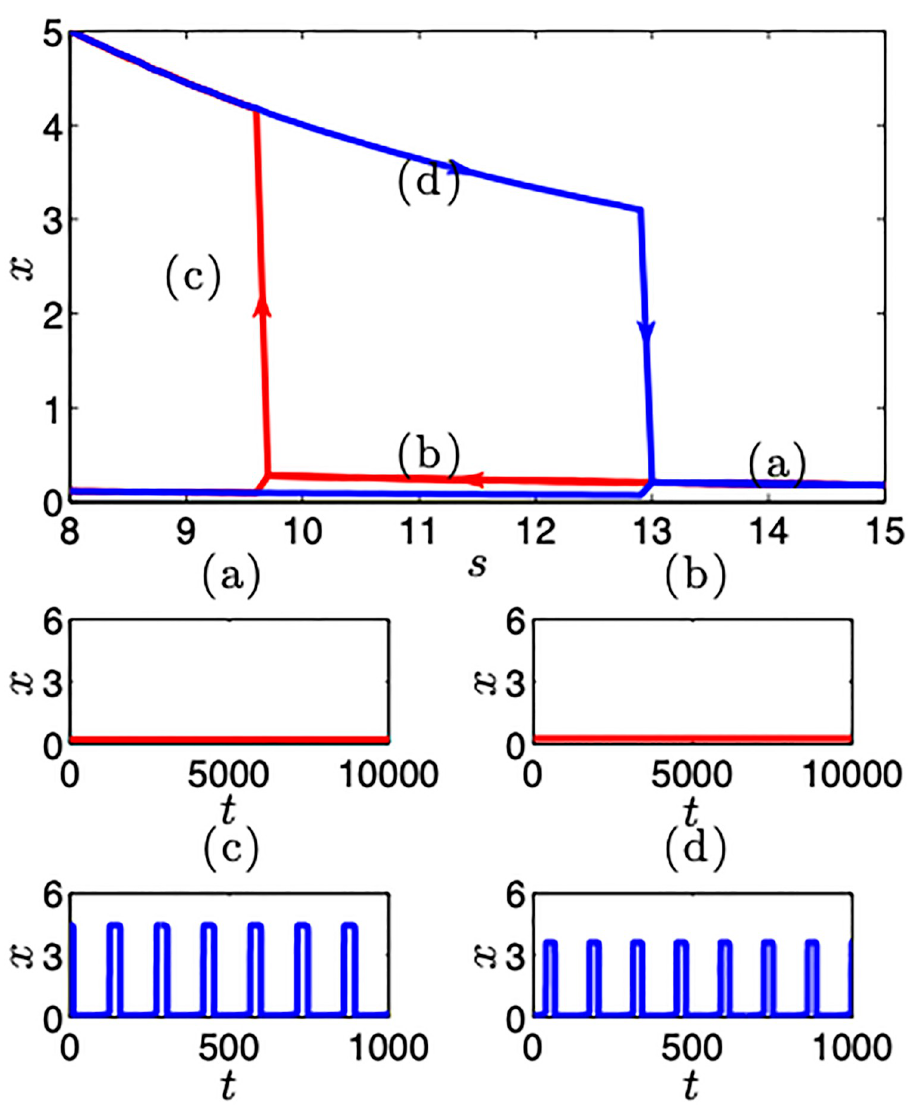
Fig 4. Learning rules generating institutional loss aversion–systemic endowment effect. Time series plot of x with s changing as s = 14( a ) ! 11( b ) ! 9( c ) ! 11( d ). In this case, once the model has reached a periodic configuration it remains so for higher values of s than when coming directly from a stable state. Institutions generate hysteresis producing an endowment-like effect whereby a state can be more readily acquired than relinquished. This maps onto the slow shifter class of collectively encoded institutional